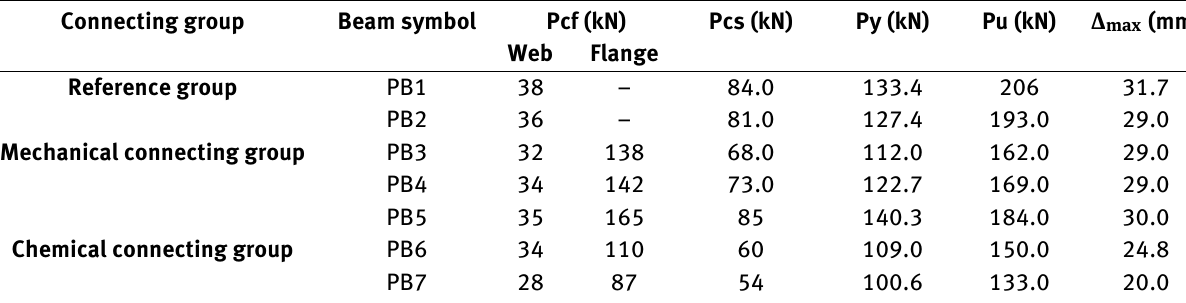
Table 3: Experimental results of tested composite beams Connecting group